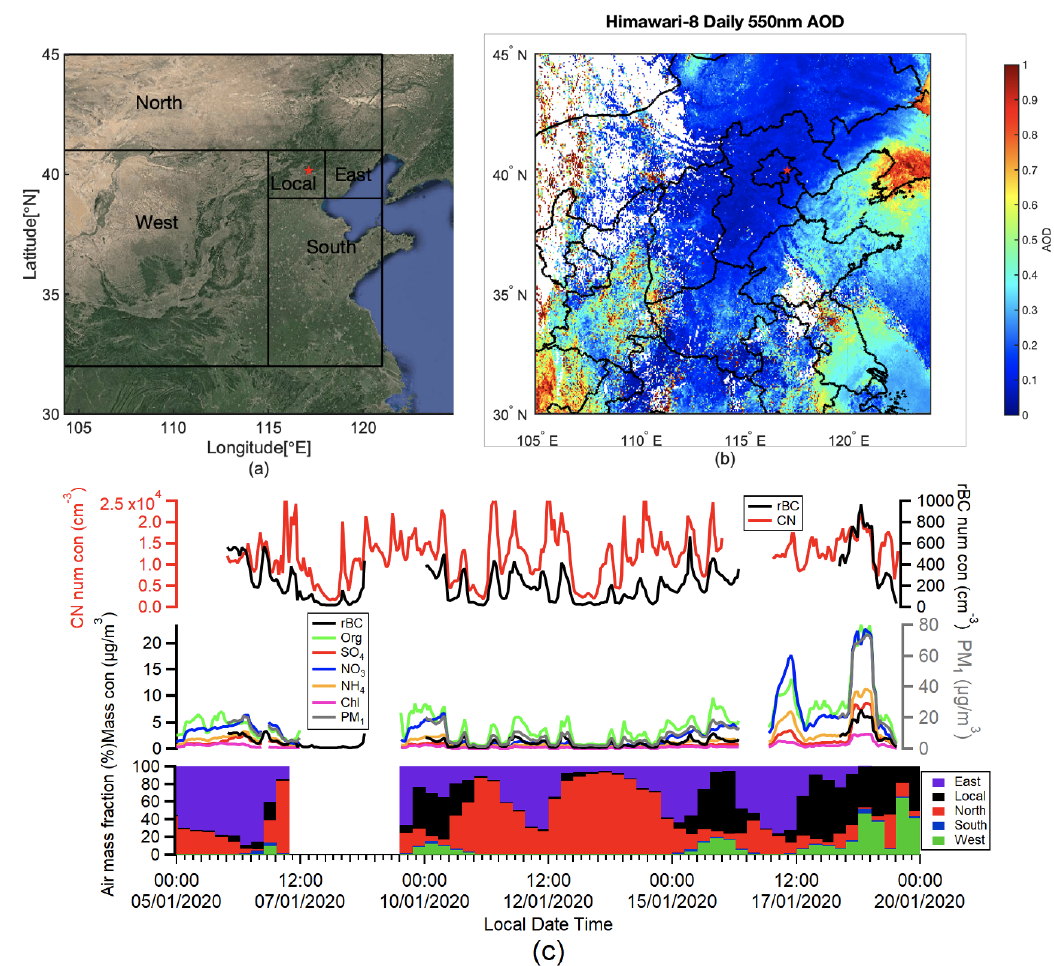
Figure 4. Overview of the experiment. (a) Location of the measurement site (marked by red star) and regions classified for air mass (from ©Google Maps). (b) The mean aerosol optical depth (AOD) distribution during the experiment period. (c) Aerosol mass and number concentrations and classified air mass